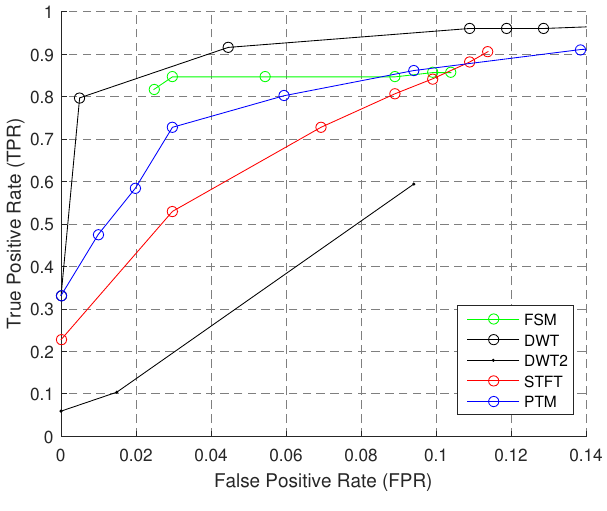
Figure 13. ROC of step counting: Hand.